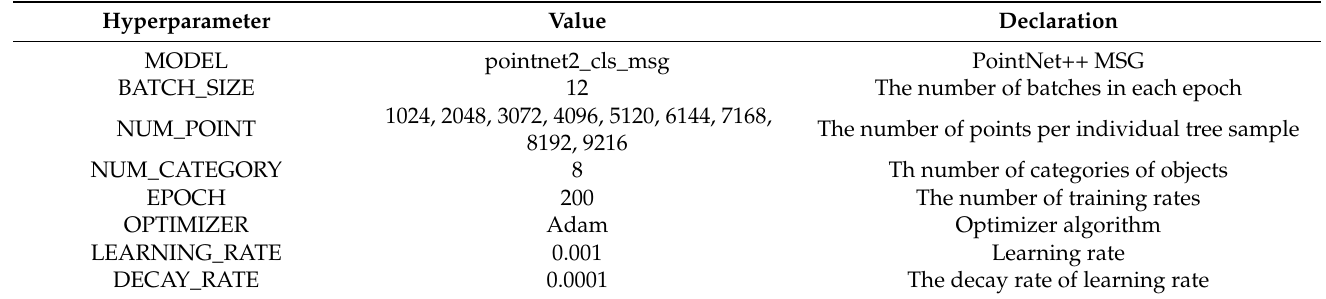
Table 3. Hyperparameters of the model and parameters of the optimal